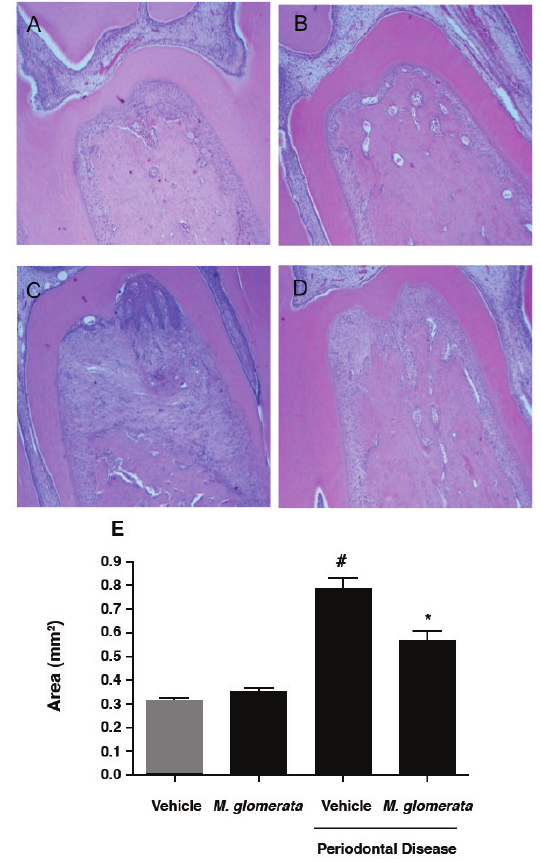
Figure 1- Mikania laevigata extract (MLE) decreases alveolar bone resorption. Histology at the furcation of first molars sampled from the rats euthanized after 30 days of experiments is shown [hematoxylin and eosin(HE) staining]; (A) non-ligated animals treated with vehicle, (B) non-ligated animals treated with (MLE) (10 mg/kg/day for 30 consecutive days), (C) ligature-induced periodontitis treated with vehicle for 30 days, (D) ligature-induced periodontitis treated with subcutaneous MLE (10 mg/kg/ day for 30 consecutive days). (E) Results are expressed as mean area (mm 2 ) ± standard deviation of 10